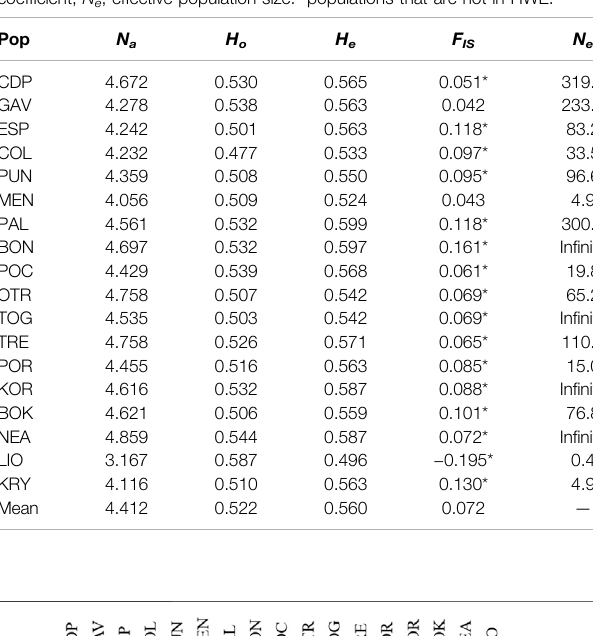
TABLE 3 | Genetic diversity and effective population size estimates for the 18analysed populations of C. caespitosa . N a ,standardised number ofalleles; H o , observed heterozygosity; H e , expected heterozygosity; F IS , inbreeding coef fi cient; N e , effective population size. *populations that are not in HWE.